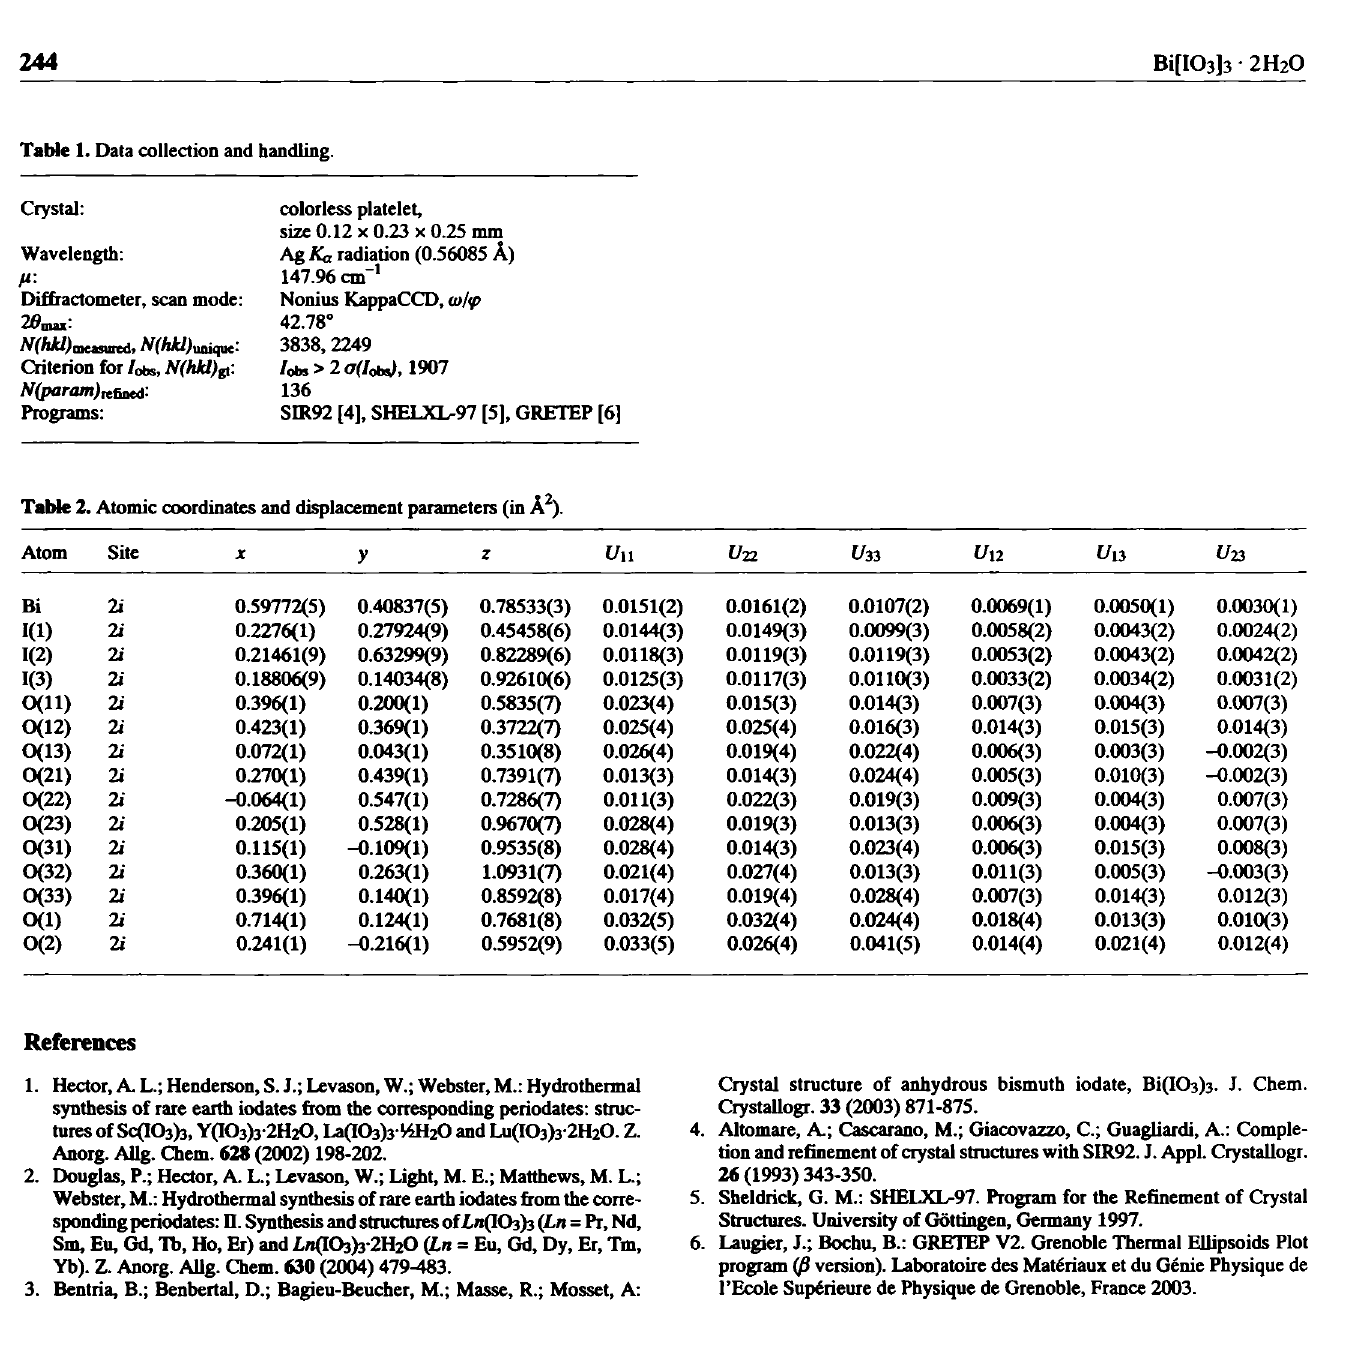
Table 1. Data collection and handling.